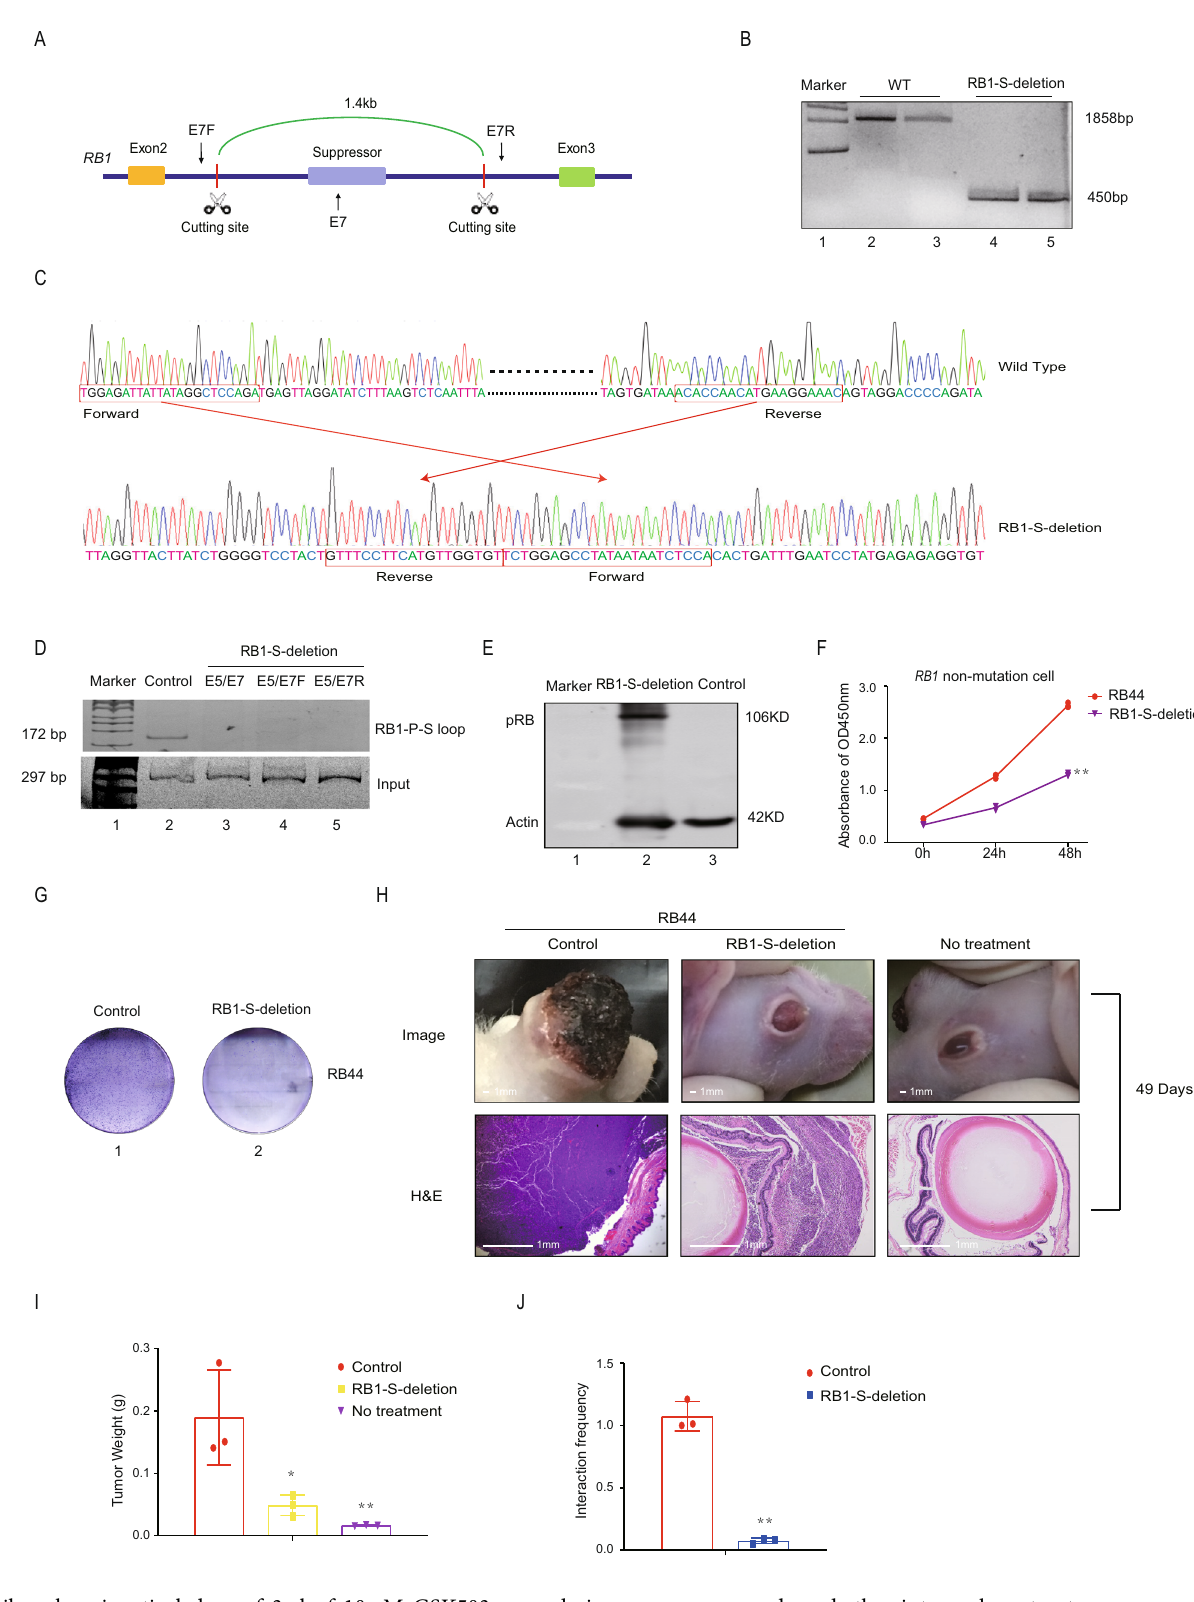
was suppressed and the intraocular structure was retained (Fig. 6d). We also noticed that GSK503 signi fi cantly reduced the tumor weight (Fig. 6e). A heterotopic transplantation model was used for IM9 cells. Subcutaneous injection of 3 µl of 10 µM GSK503 was carried out for 7 days once the tumor formed,